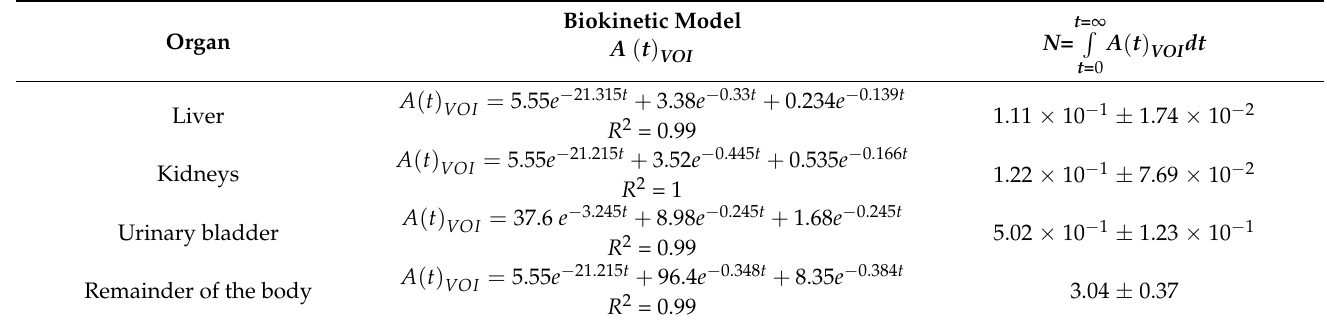
Figure 2. Blood clearance of [ 99m Tc]Tc ‐ iFAP from healthy subjects with t 1/2 α = 2.22 min (70.4%) and t 1/2 β = 90 min (29.6%). Inset: proposed chemical structure for the [ 99m Tc]Tc ‐ iFAP radioligand. Table 1. Mean biokinetic model of [ 99m Tc]Tc ‐ iFAP and total nuclear transformations (N) (MBq . h/MBq) (mean ± SD) in source organs calculated from six healthy volunteers using a hybrid 2D ‐ planar/3D ‐ SPECT methodology.